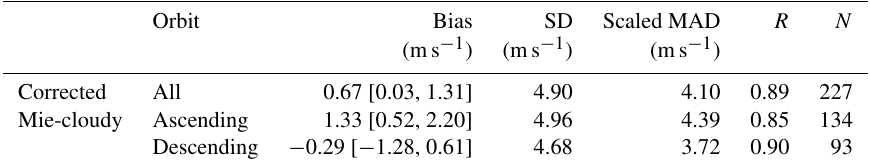
Table A1. Results of inter-comparison with ground-based WPR measurements for corrected Mie-cloudy